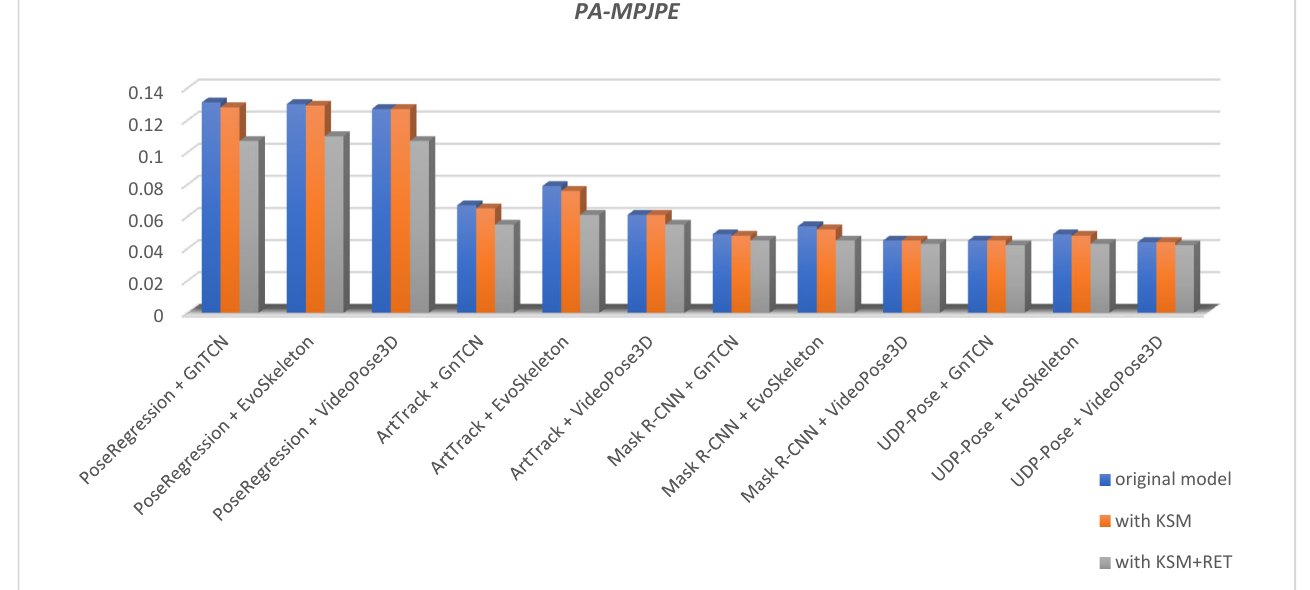
Figure 17. Comparison of pose sequence estimation in terms of PA ‐ MPJPE measure on Human3.6M datasets (lower is better). All models show a slight improvement when using smoothing on the sequence of poses, showing the lack of consistency in the detection location of keypoints and “lifting” 2D keypoints to the 3D space. An exception to this conclusion is the VideoPose3D model, which constructed a smooth sequence of poses by utilizing temporal information. When using retargeting on the ground truth and smoothed predicted sequence, results are significantly improved, which indicates that all models lack an understanding of the human skeleton structure.